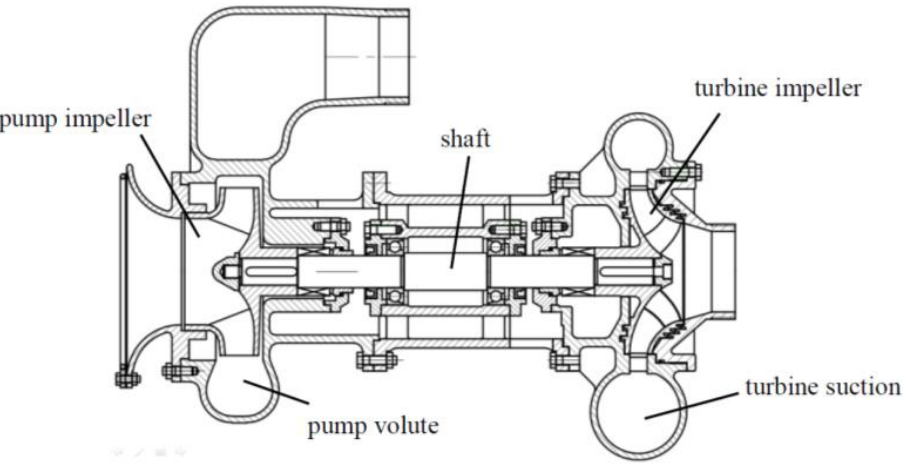
Figure 1. Fire turbopump structure.